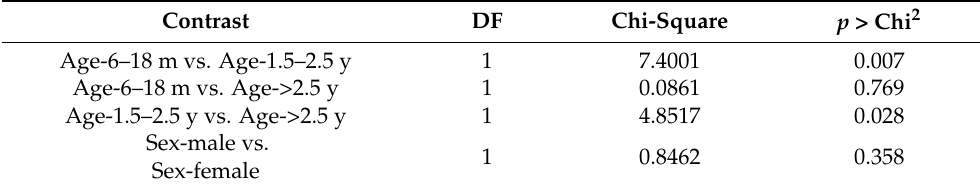
Table 11. Results of mutual comparisons of the significance of the differences of different age groups of wild boars and different